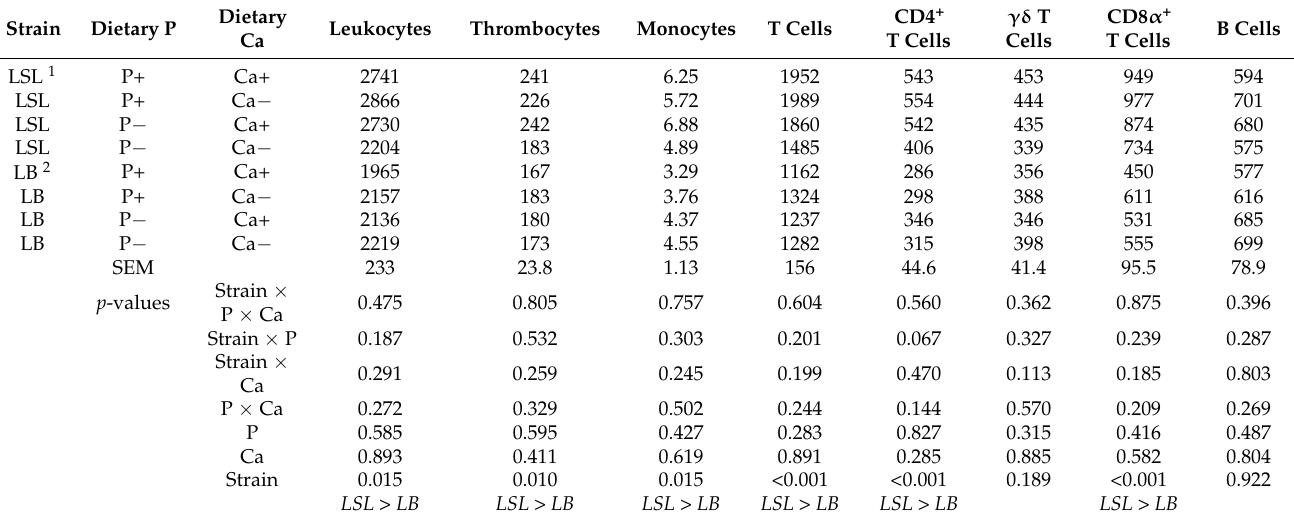
Table 2. Effect of strain, dietary P and Ca on the number of immune cells ( × 10 6 ) in the spleen. Strain Dietary